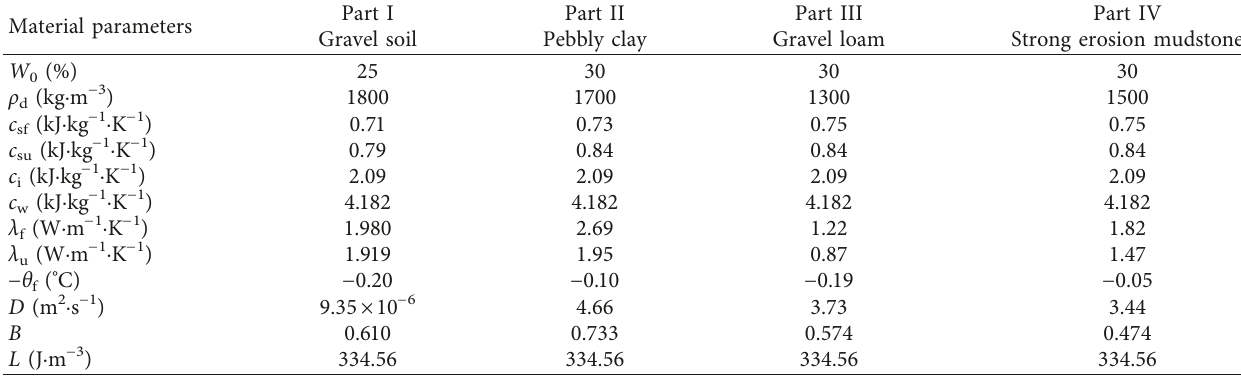
Table 3: Material parameters for different soils.